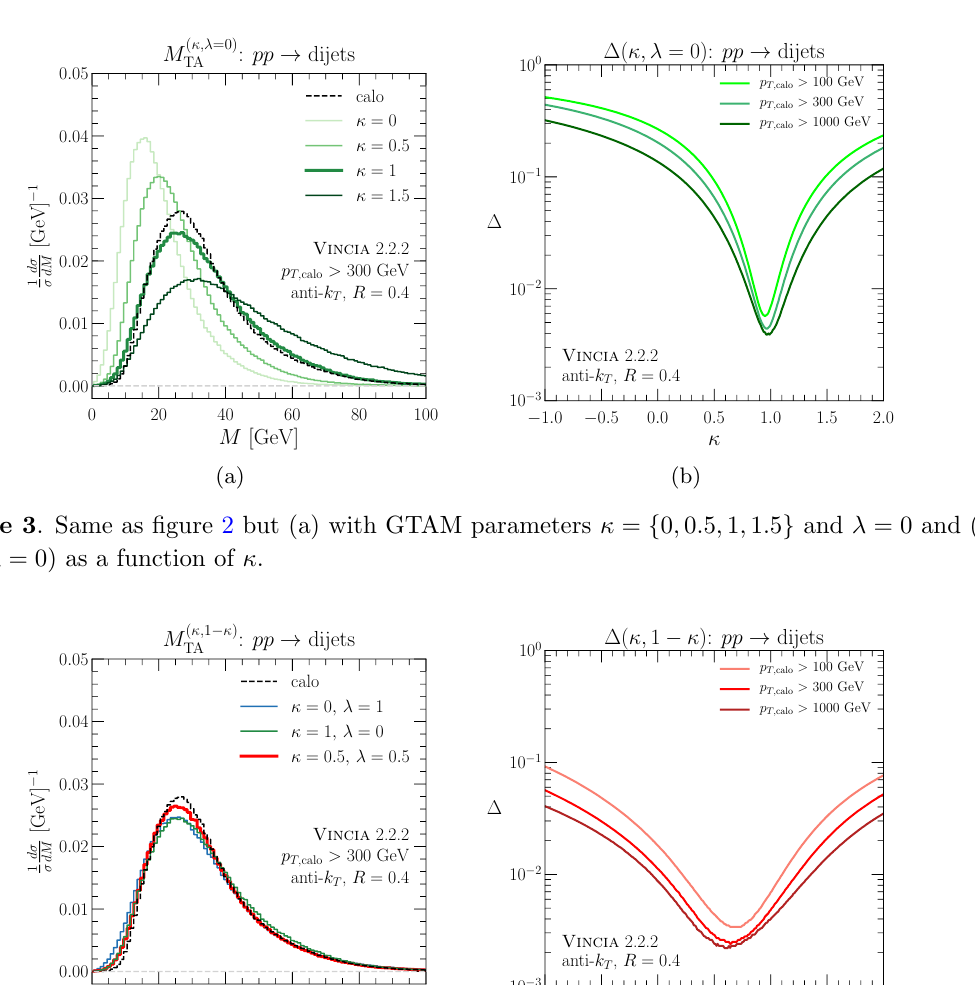
(0 ; 1) ; (0 : 5 ; 0 : 5) ; (1 ; 0) f